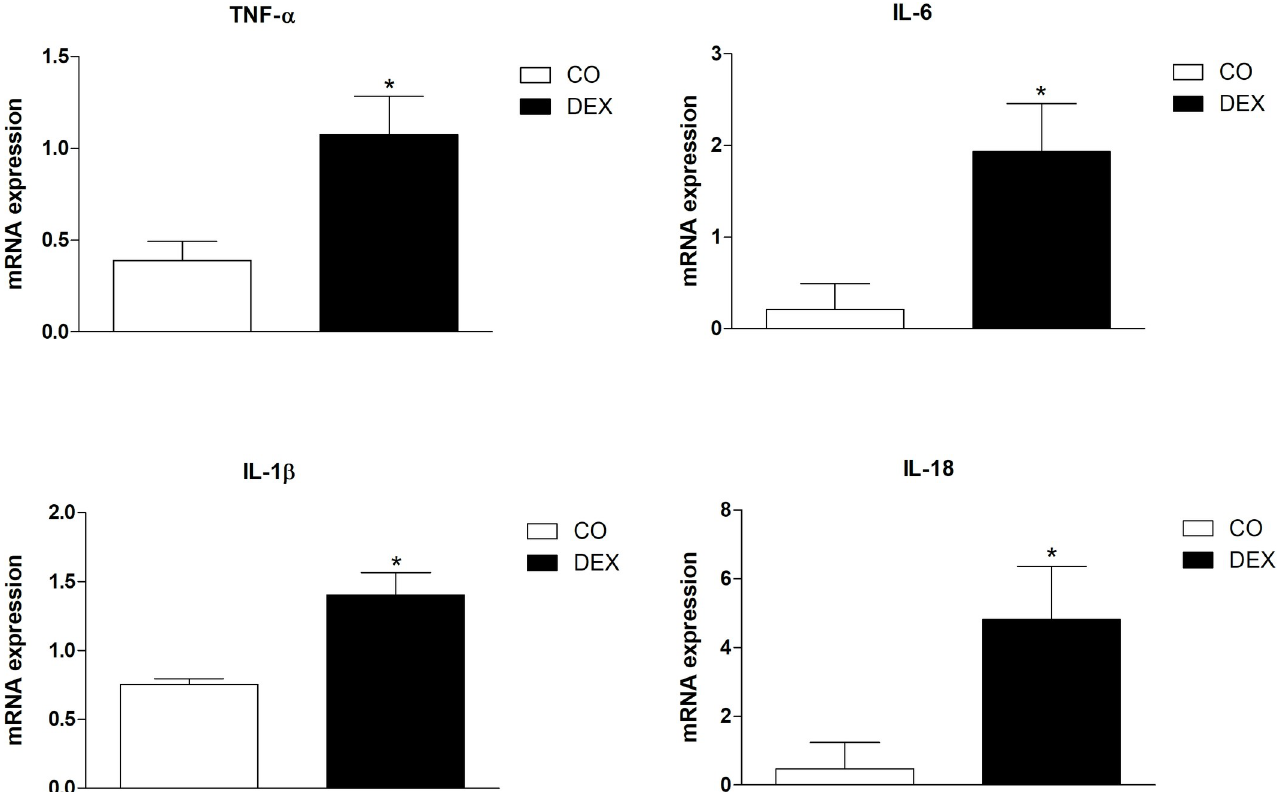
Fig 6. Effects of insulin resistance on pro-inflammatory cytokine gene expression in mesenteric artery of control (CO) and dexamethasone treated (DEX) groups. The results are expressed as the mean ± SEM, n = 3. For data analysis, Student’s unpaired t-test was used. � p < 0.05, �� p < 0.01 CO vs DEX.